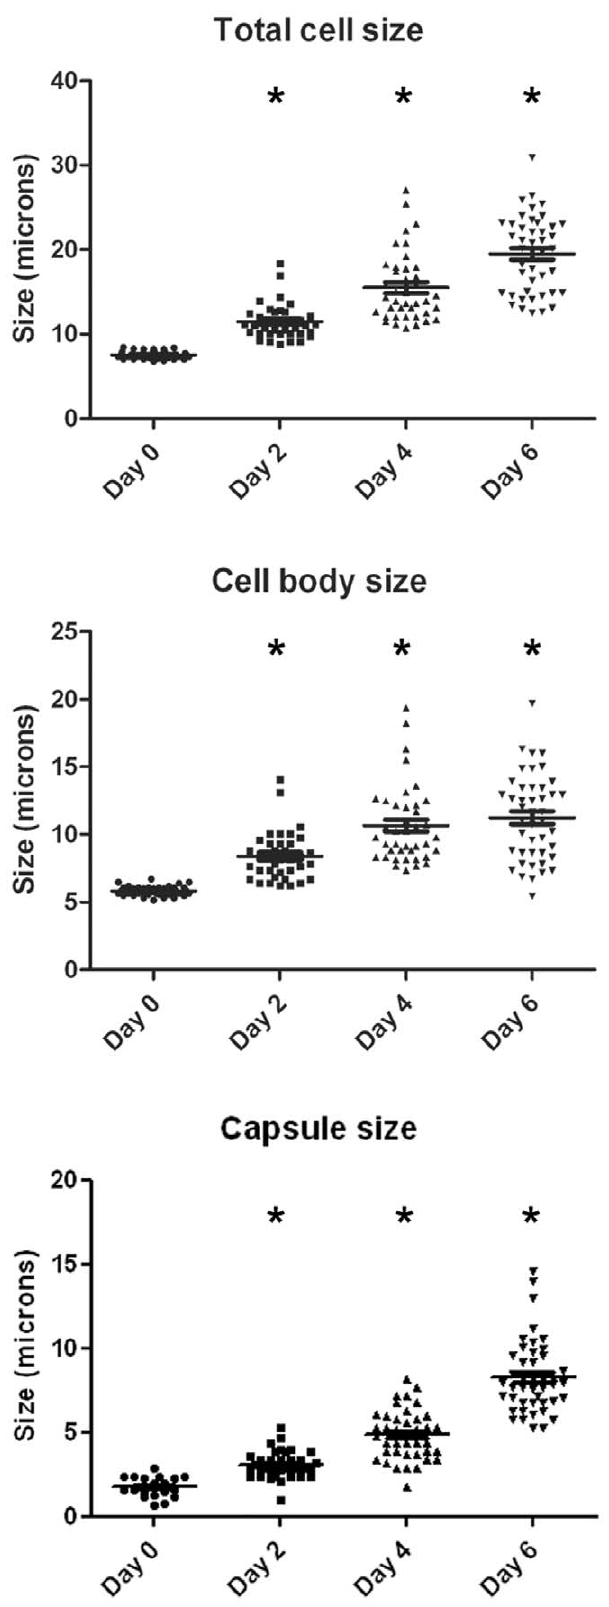
Figure 2. Morphogenesis of C.neoformans during infection in G. mellonella . Distribution of total cell size, cell body size and capsule diameter of C. neoformans cells grown in Sabouraud (T=0)